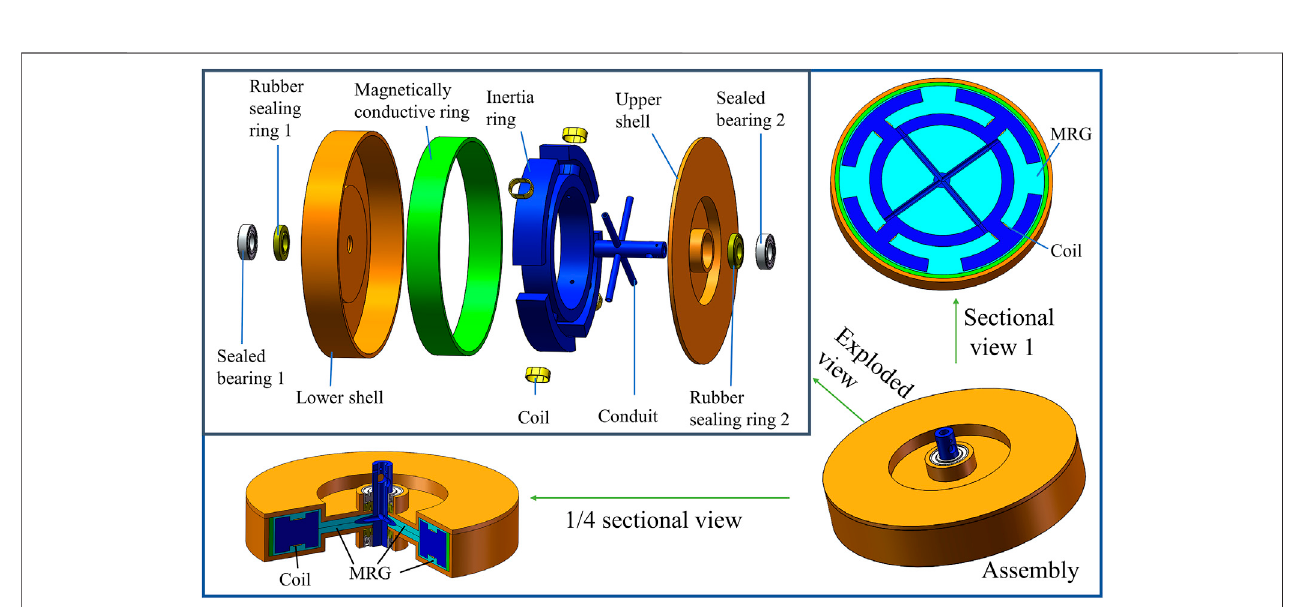
FIGURE 3 | h variation curve: (A) h - slip curve and (B) h-t curve of each working condition.